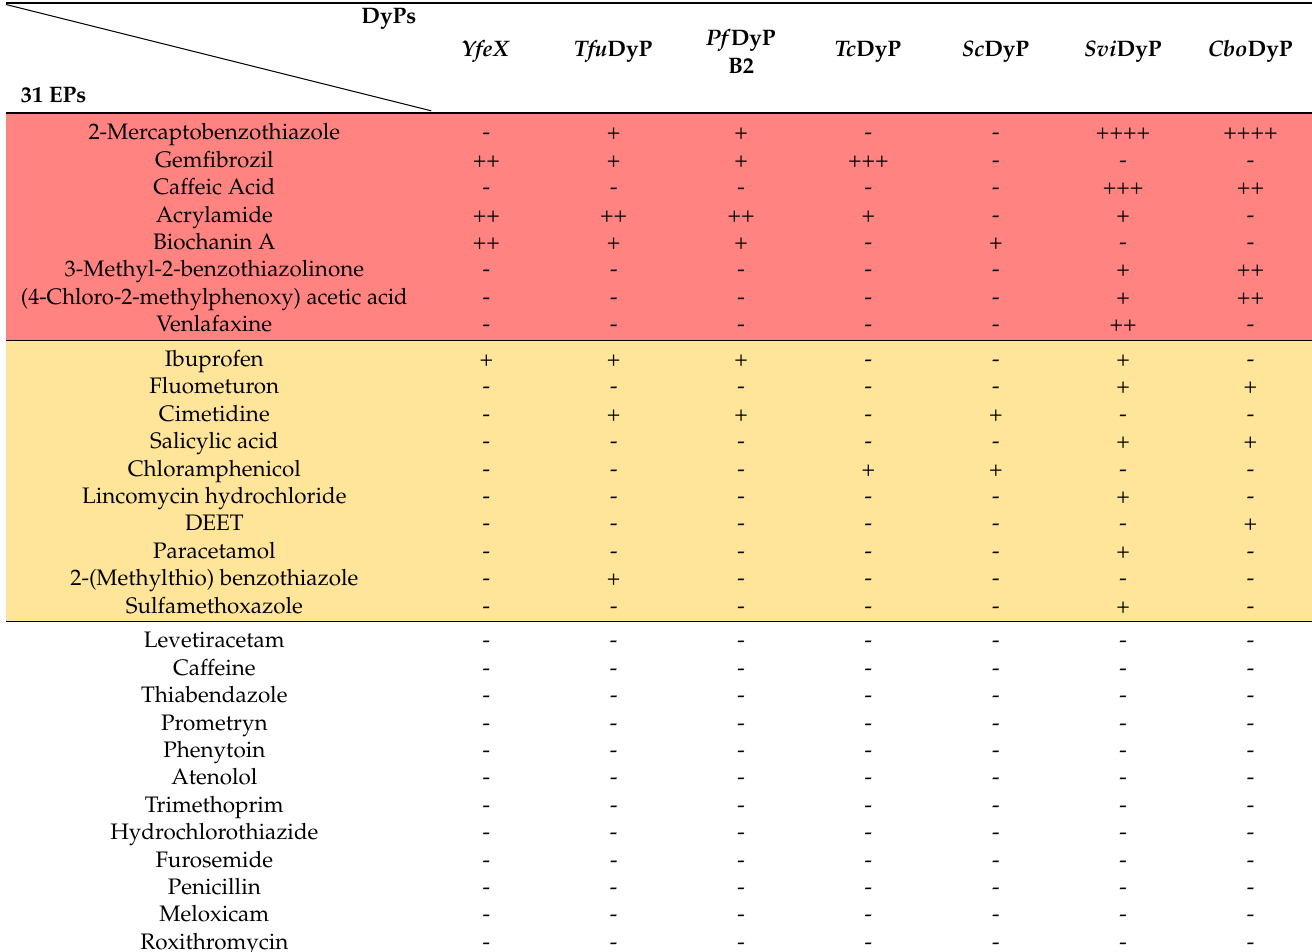
Table 2. Degradation profiles of 31 EPs upon treatment by seven rDyPs, as described under Materials and Mathods. EPs remaining after enzymatic treatment are indicated as follows: (++++) = 0–25% remaining of pollutant, (+++) = 25–50%, (++) 50–75% remaining, (+) = 75–90% remaining, (-) = < 90% remaining. Rows shaded in light red show most pronounced degraded EPs, those in light yellow represents EPs showing relatively low degradation, while EPs in unshaded rows showed no detectable degradation by any of the